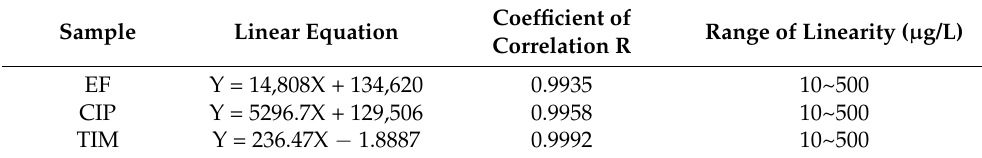
Table 2. Standard curve equations and related coefficients.